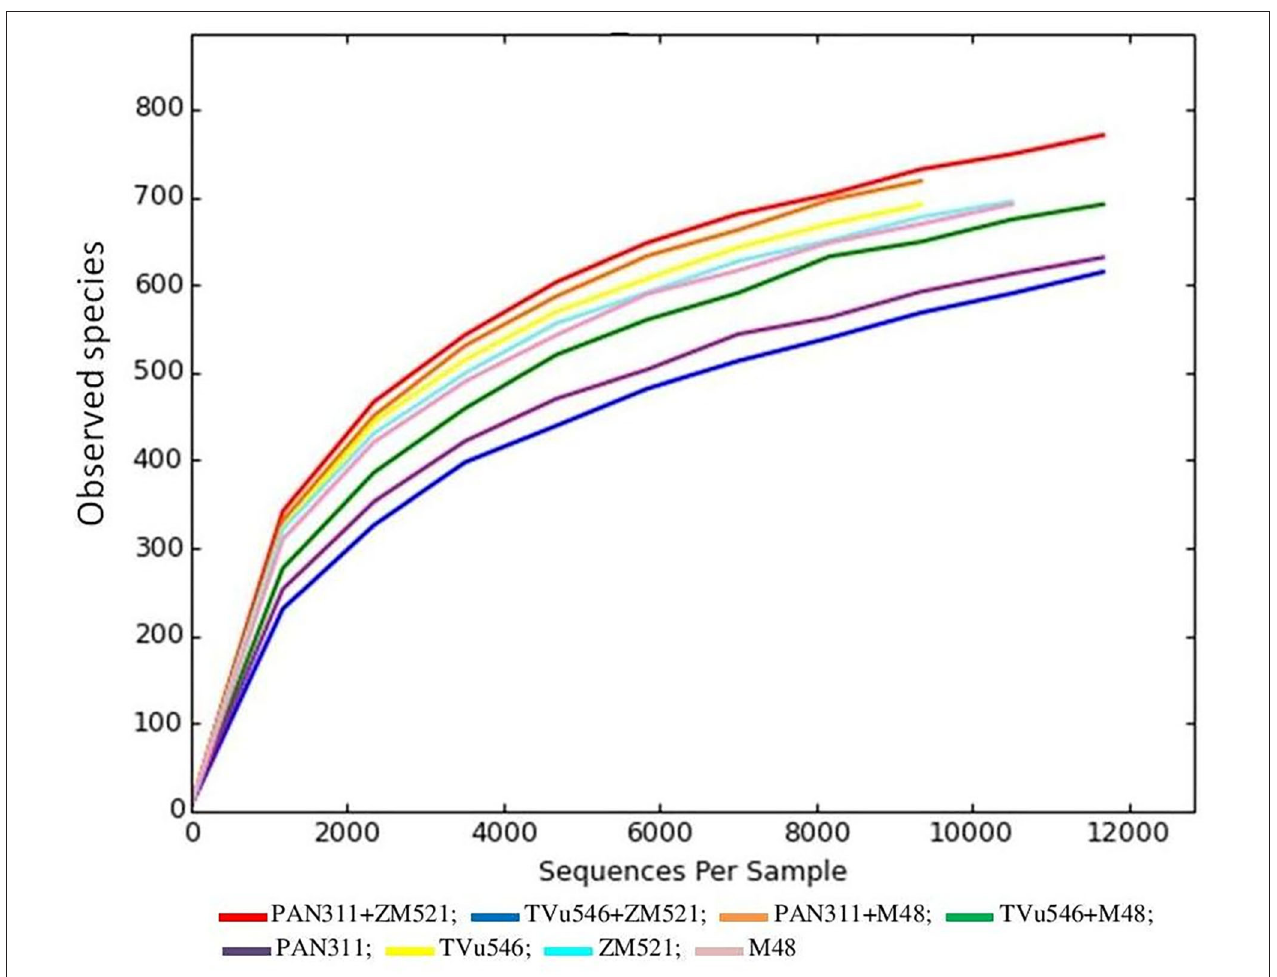
FIGURE 5 | Rarefaction curves of all samples were generated for observed microbial species which contained unique sequences and were defined at 97% sequence